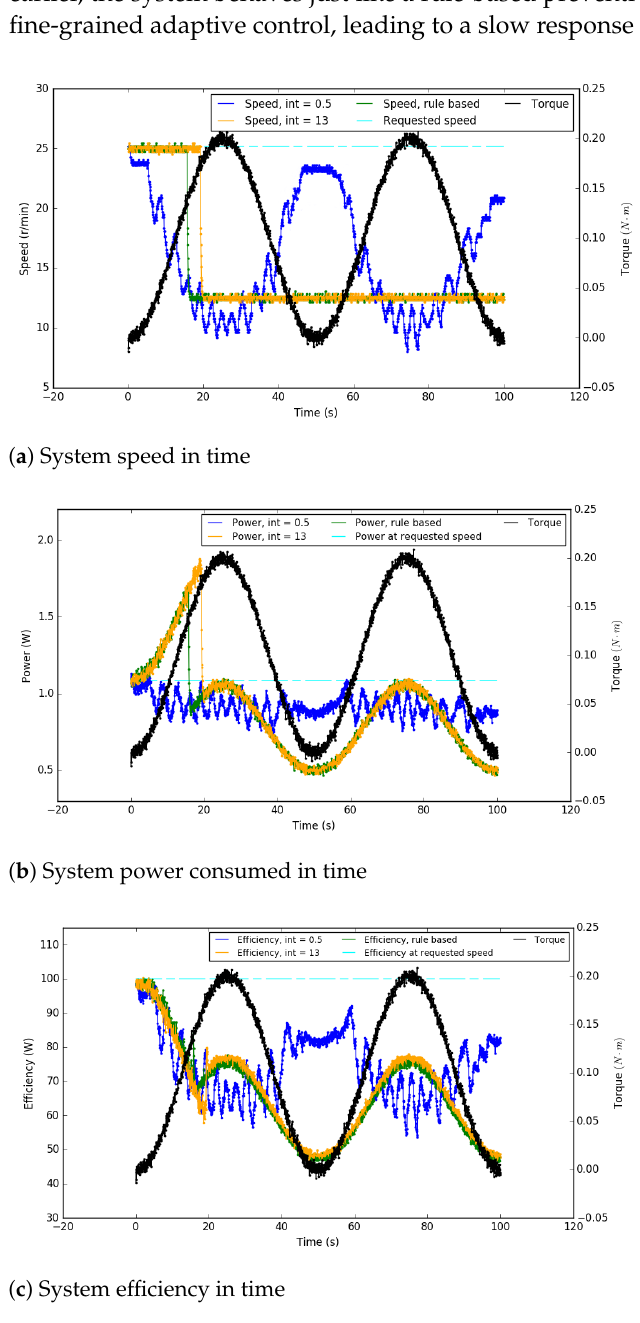
Figure 11. Performances of our PM-based adaptive control with interval = 0.5 r/m, 13 r/m and the rule-based